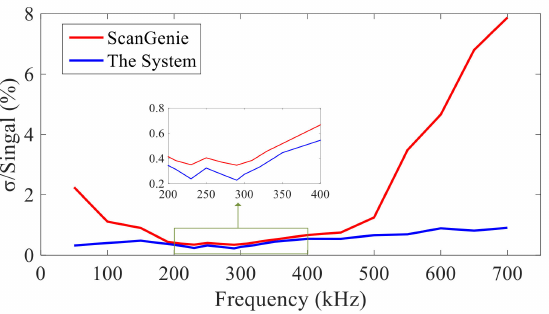
Figure 14. System repeatability test at the frequency of 50–700 kHz actuation